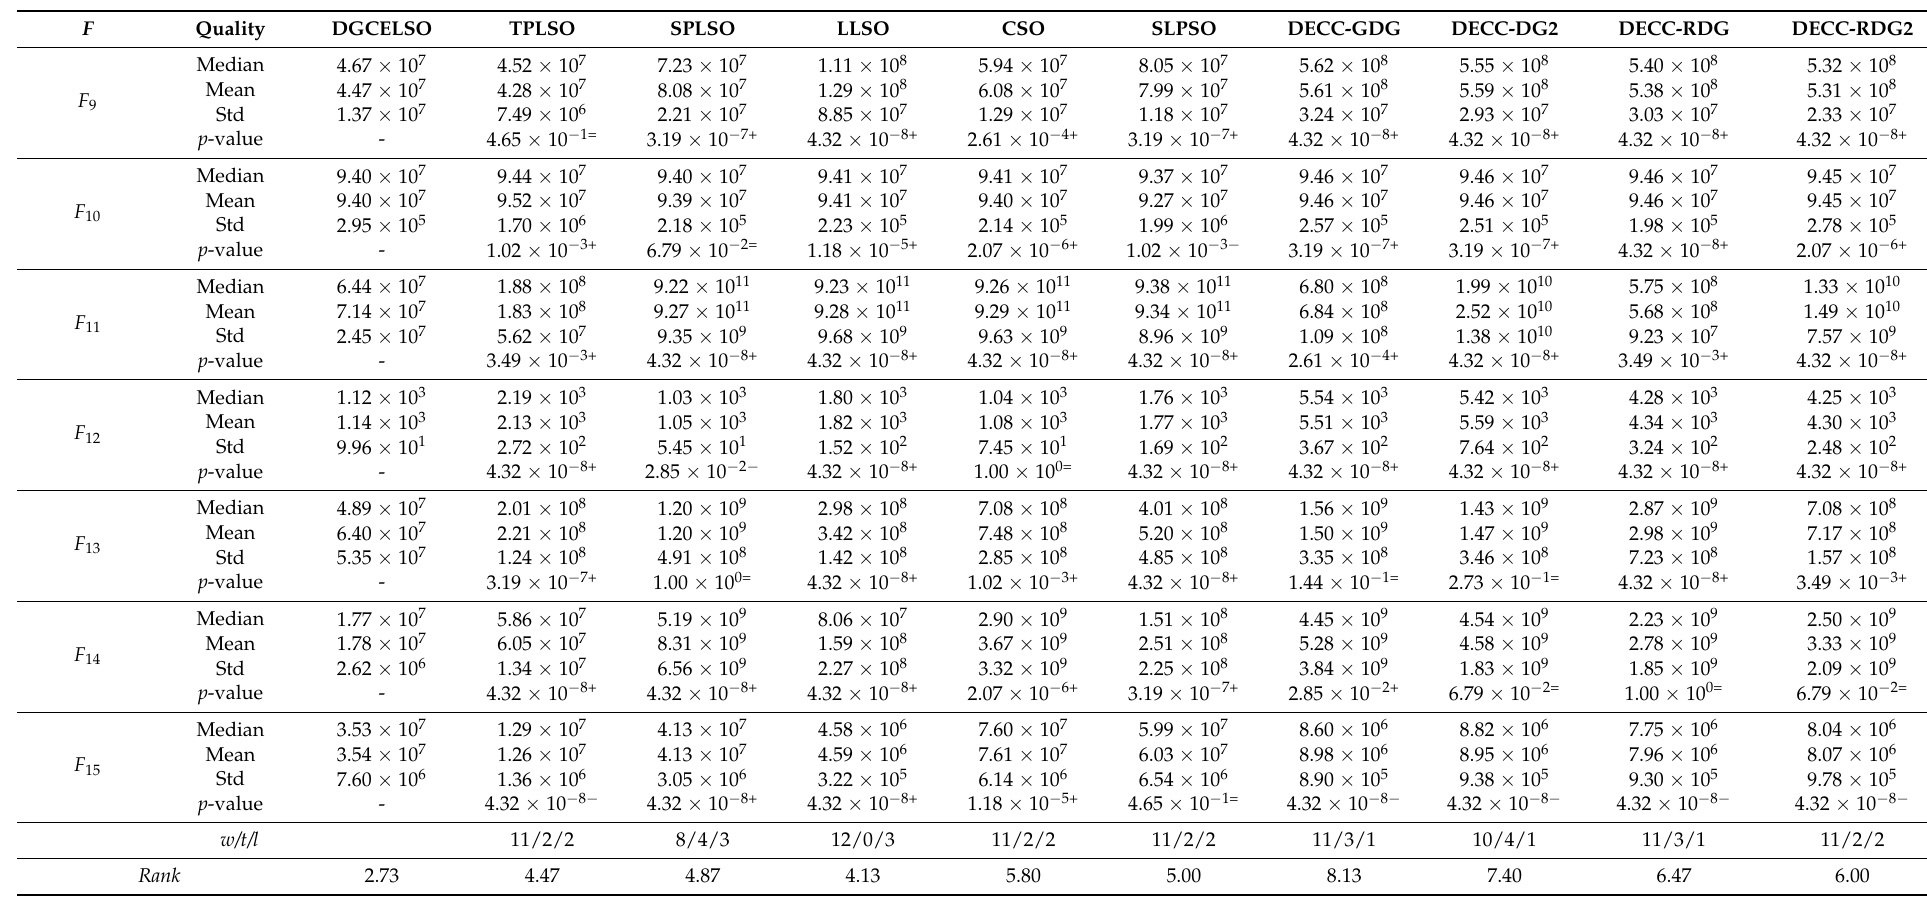
Table 4. Fitness comparison between DECELSO and the compared algorithms on the 1000-D CEC’2013 problems with 3 × 10 6 fitness